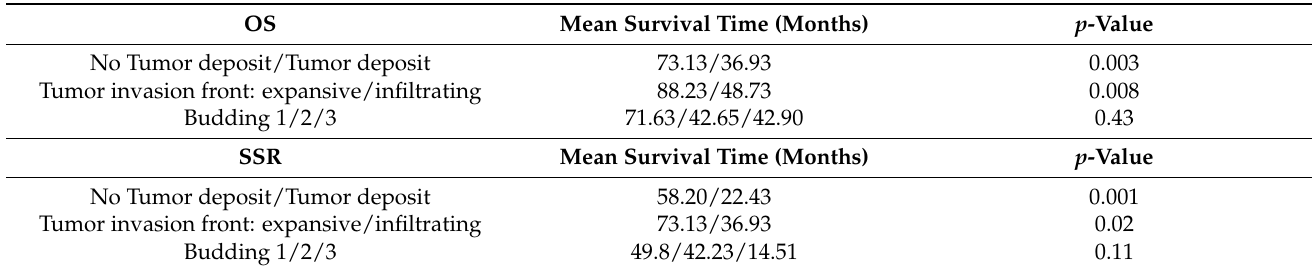
Table 3. Results of the log rank test: mean survival time according to prognostic factors studied in 229 patients with colon cancers for overall (OS) and recurrence-free survival (SSR).